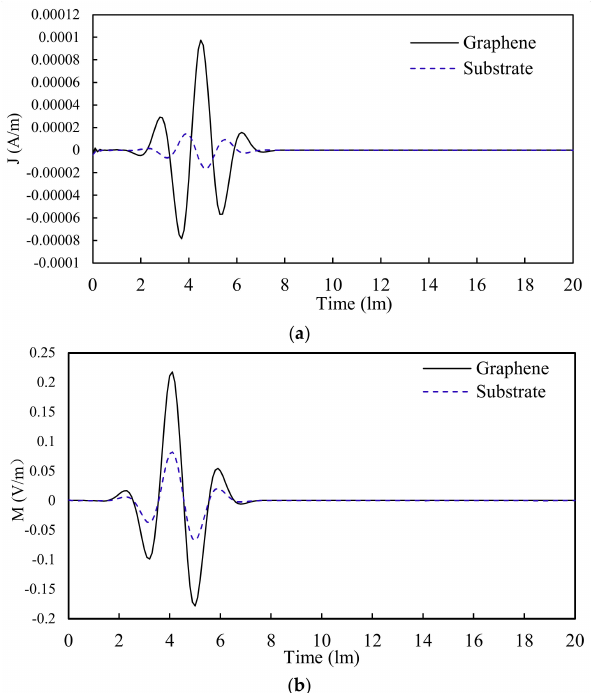
Figure 5. Transient currents across two example inner edges of the graphene and substrate: ( a ) electrical current; ( b ) magnetic